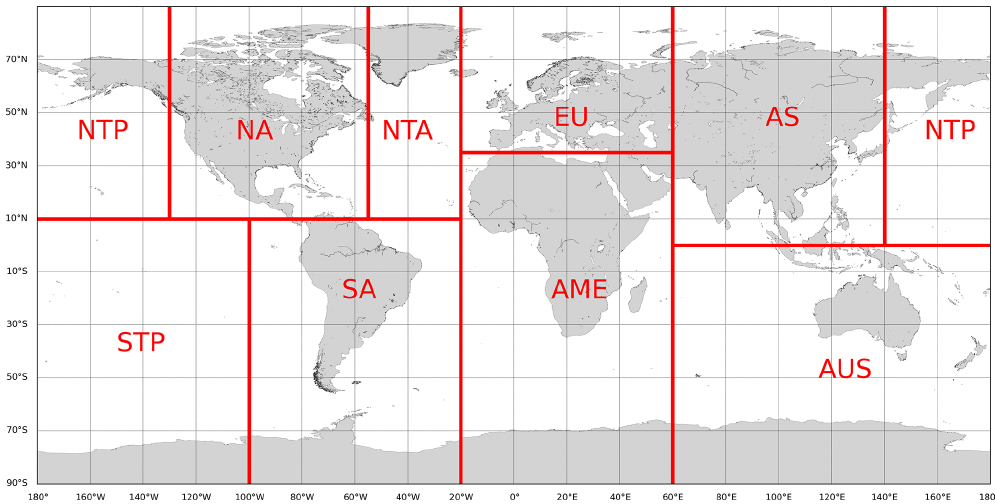
Figure 2. Regional divisions for source–receptor analysis based on RF (NTA: Northern Trans-Atlantic, NA: North America, NTP: Northern Trans-Pacific, EU: Europe, AS: Asia, STP: Southern Trans-Pacific, SA: South America, AME: Africa & Middle East and AUS: